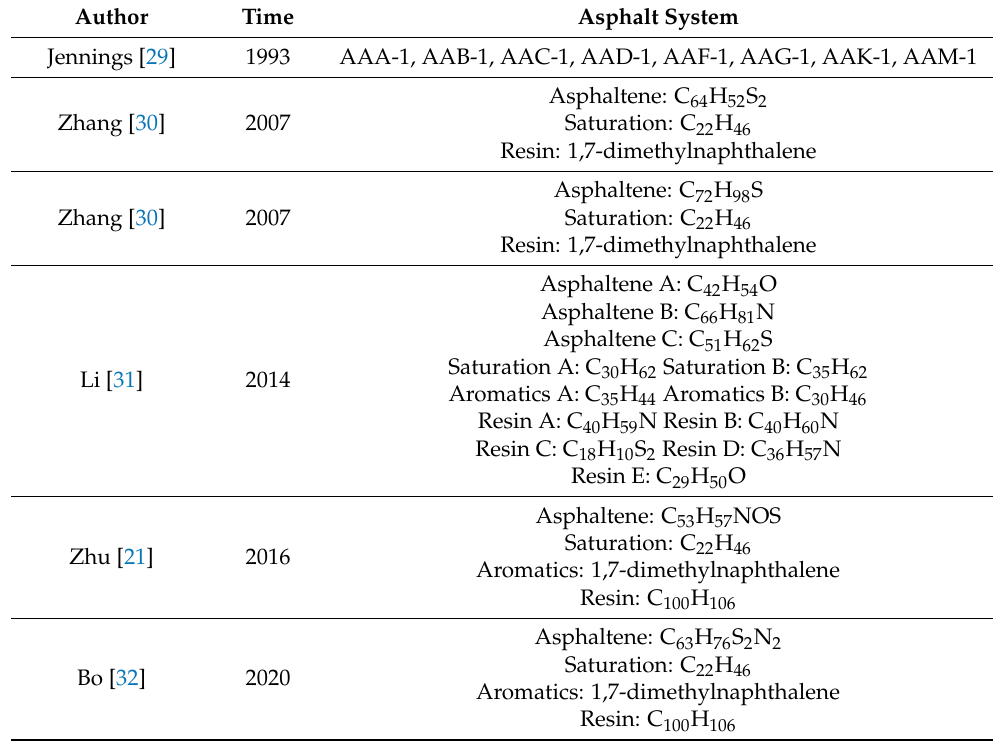
Table 1. Molecular composition of typical bitumen